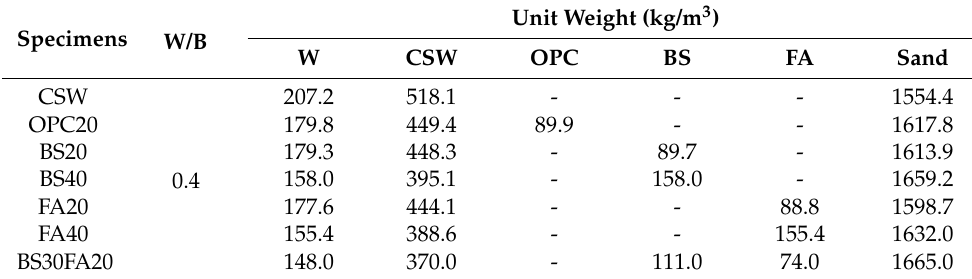
Table 7. Mixture proportion—mortar